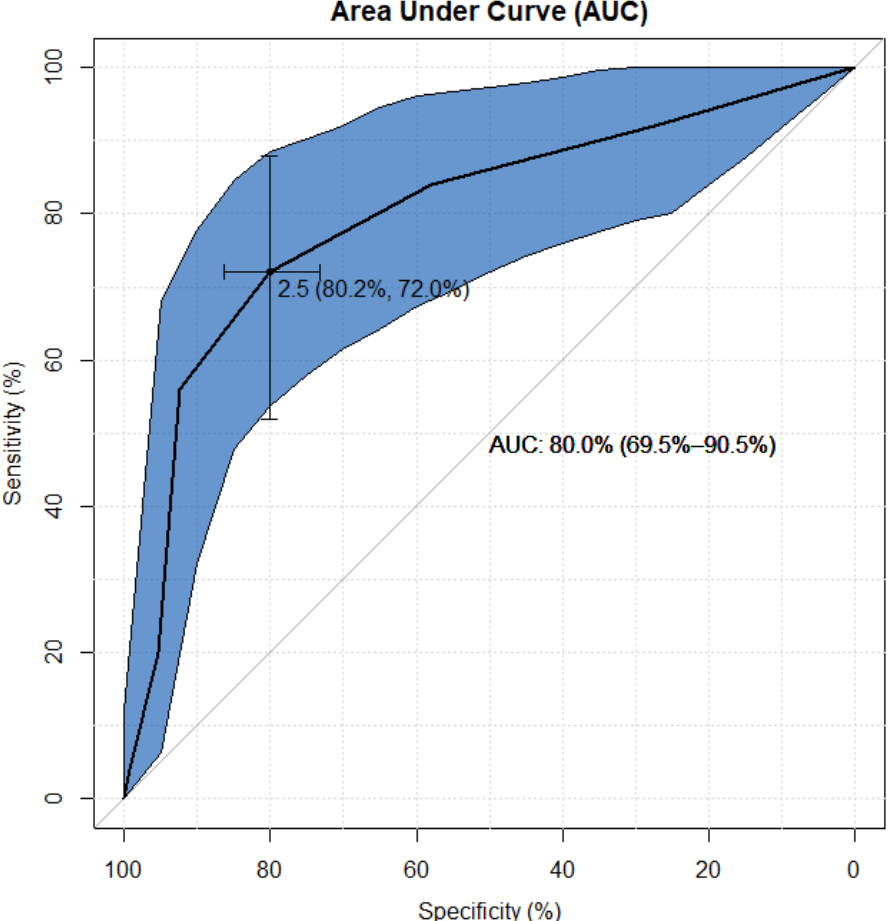
Figure 3. ROC analysis of ETA receptor expression score for detecting AMR status. The most appropriate cut-off for the test of the chosen binary classifier is between 2 and 3 of the summarized ETA receptor expression score at the highest true positive rate, together with the lowest false positive rate, which amount to 72% and 80%, respectively (see Figure 2). Based on the calculated AUC, it can be established that the accuracy of the classification of positive AMR using the level of summarized ETA receptor expression score reached 80% (since the lower limit of the AUC 95% confidence interval is greater than 50%, this result should be considered statistically significant, i.e., p > 0.05). Then, it allows to state that 80% of patients would be correctly diagnosed taking only the level of the summarized ETA receptor expression score into account.